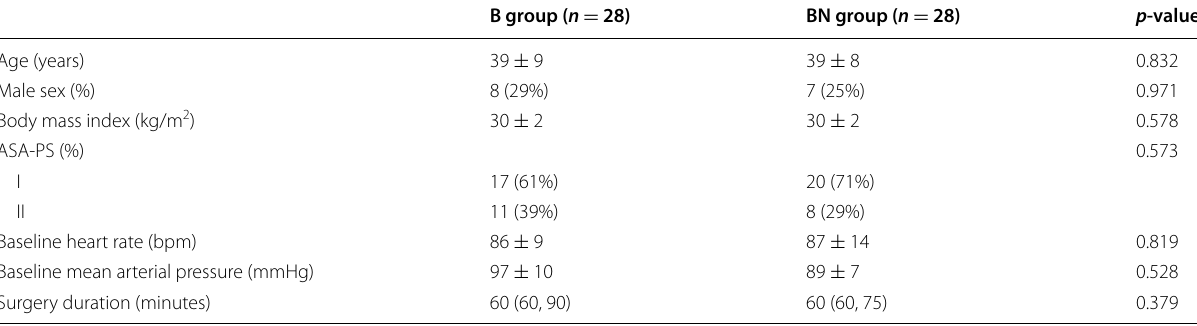
Table 1 Demographic data and baseline hemodynamics characteristics. Data presented as mean (quartiles), and frequency